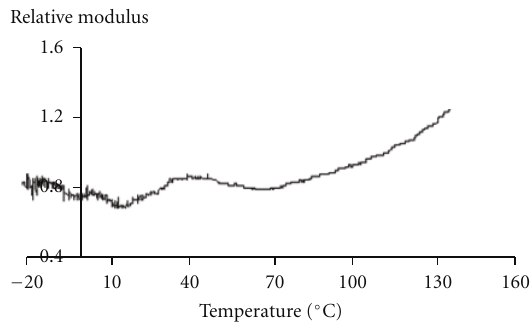
Figure 8: Loss modulus variation of unfilled (1) and mica-filled (2) polypropylene.